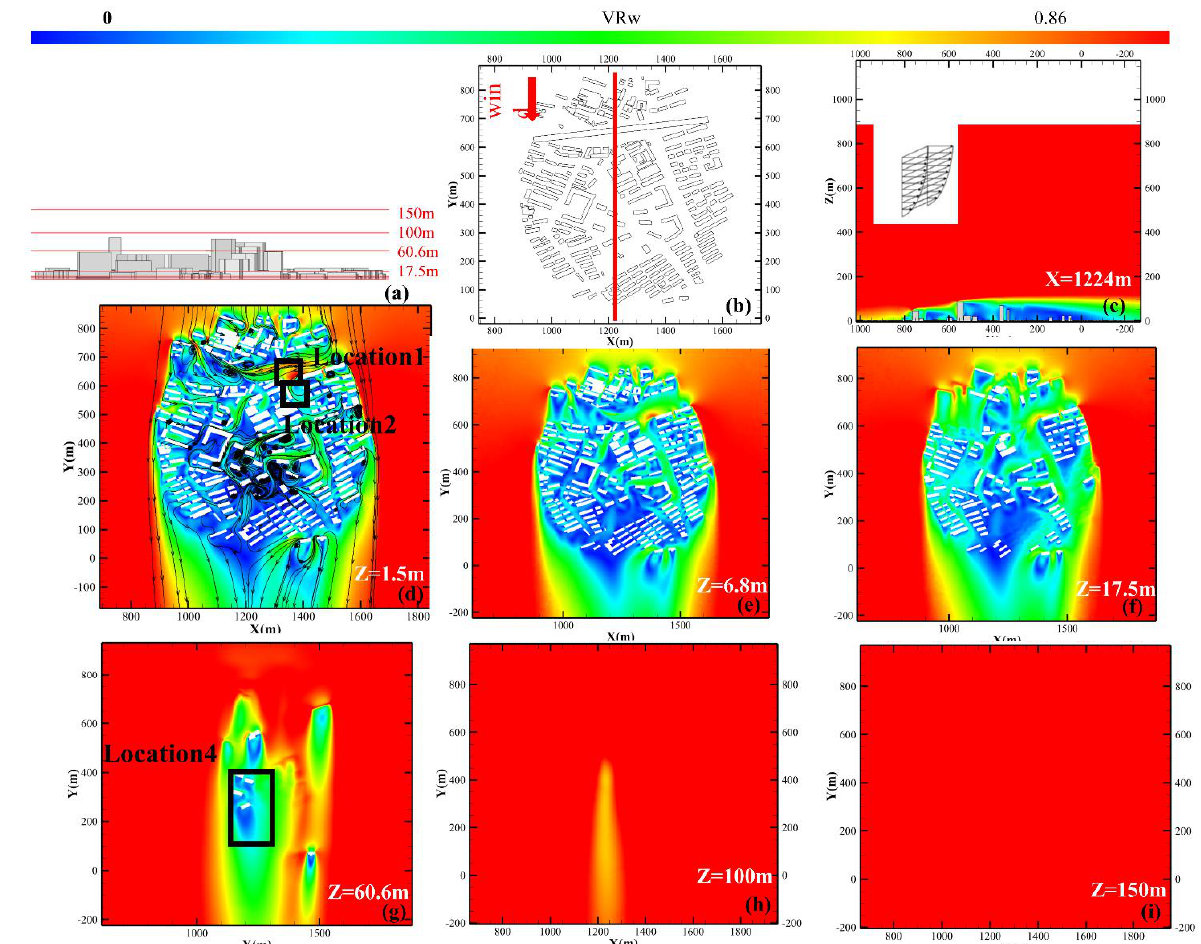
Figure 6. Cross – section display of study area ( a , b ); Contours of spatially – averaged wind velocity ratio (VR w ) at planes 𝑥 = 1224 m ( c ), z = 1.5 m ( d ), z = 6.8 m ( e ), z = 17.5 m ( f ), z = 60.6 m ( g ), z = 100 m ( h ), and z = 150 m ( i ).